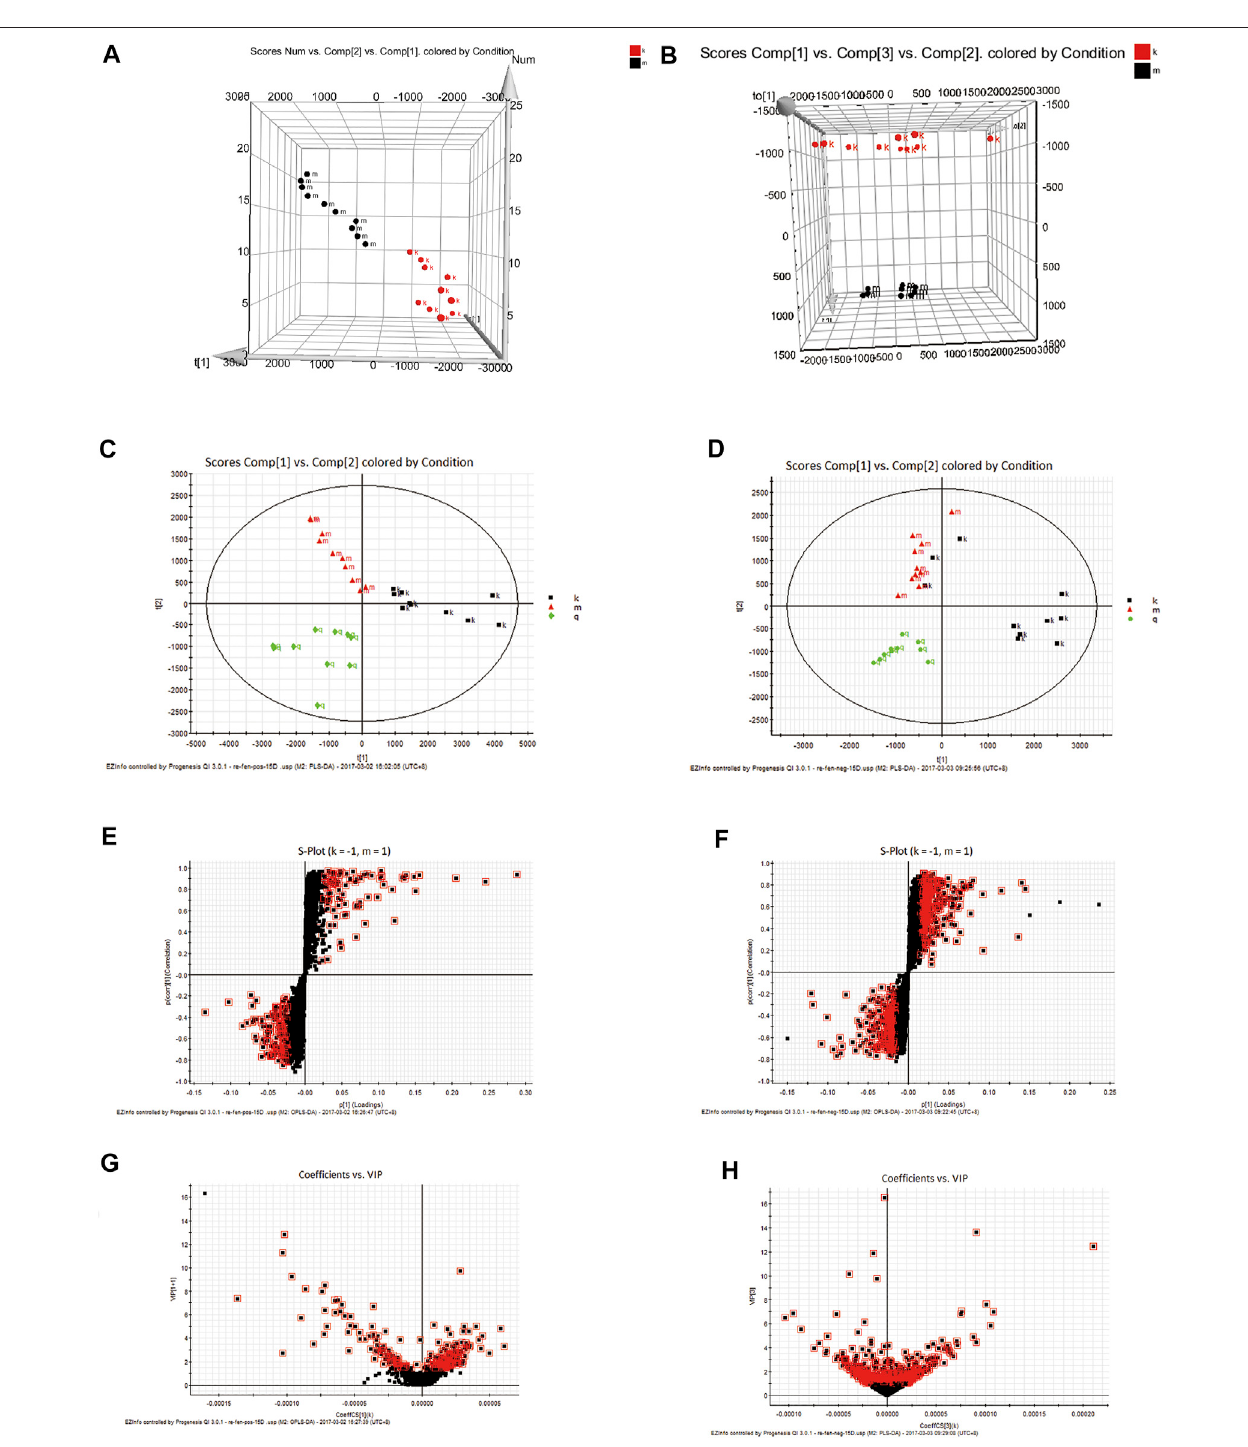
FIGURE 2 | 3D-PCA plot based on data from the Control and Model groups obtained in the positive (A) — and negative (B) — ion modes. PCA plot based on data from the Control, Model and Radix Scrophulariae groups obtained in the positive (C) — and negative (D) — ion modes (n (cid:1) 10). S-plots of fecal samples from the Control and Model groups obtained in both the positive (E) - and negative (F) — ion modes. VIP plots of fecal samples from the Control and Model groups obtained in both the positive (G) — and negative (H) -ion modes.